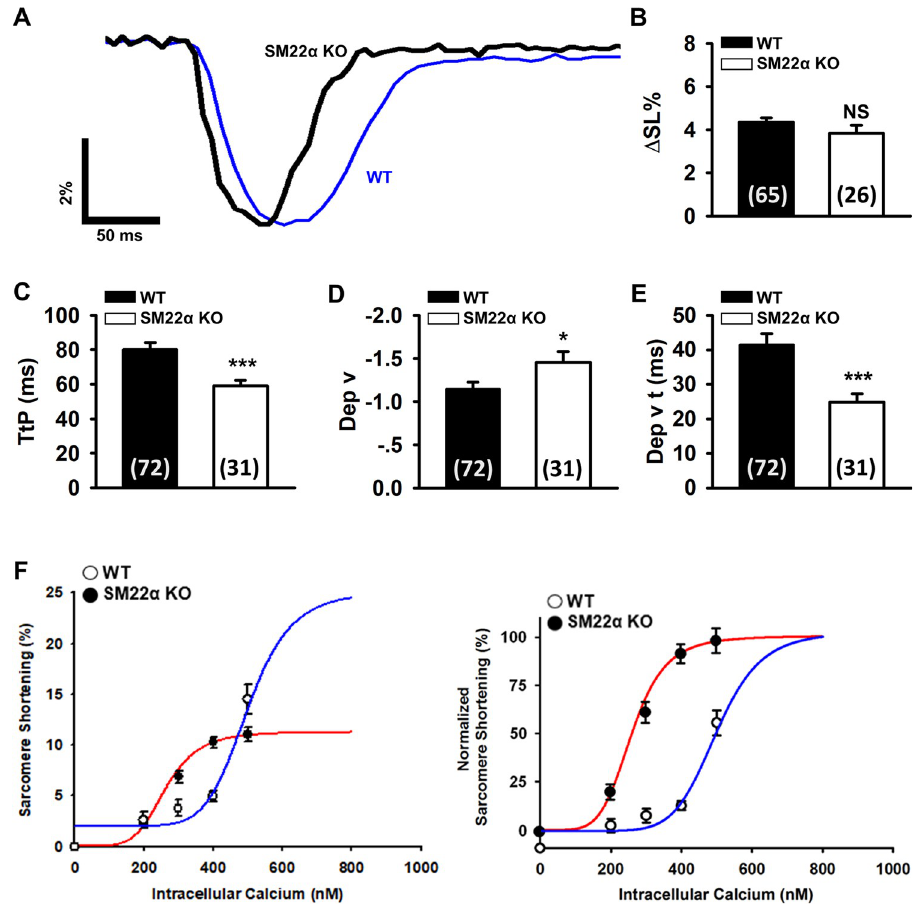
Fig 6. SM22 α KO cardiomyocytes display altered kinetics of cell shortening. (A) Representative tracings showed altered kinetics of cell shortening in SM22 α KO cardiomyocytes. (B) The amplitude of contraction of the cardiomyocytes. (C-E) Bar graphs showing decreased TtP (C), increased Dep v (D) and reduced Dep v t (E) in SM22 α KO mice (n = 72 cells from 6 WT mice; n = 31 cells from 4 SM22 α KO mice). � P < 0.05, ��� P < 0.001 vs. WT control. (F) Perfused cells with 0, 200, 300, 400, 500 nmol/L Ca 2+ buffer to record cell shortening in saponin permeabilized myocytes. Continuous lines showed Hill fits with Hill coefficients (n H ) = -6.22 and concentration for 50% of maximal effect (EC 50 ) = 515 nmol/L for WT cells, and n H = -4.99, EC 50 = 288 nmol/L for the KO cells (n = 9 or 10 from 3 mice in each group). Ca 2+ sensitivity of myofilament was increased (right), but maximum response of myofilament was decreased in SM22 α KO cells (left). Data are presented as the mean ± SEM. � P < 0.5, ��� P < 0.001 vs. WT